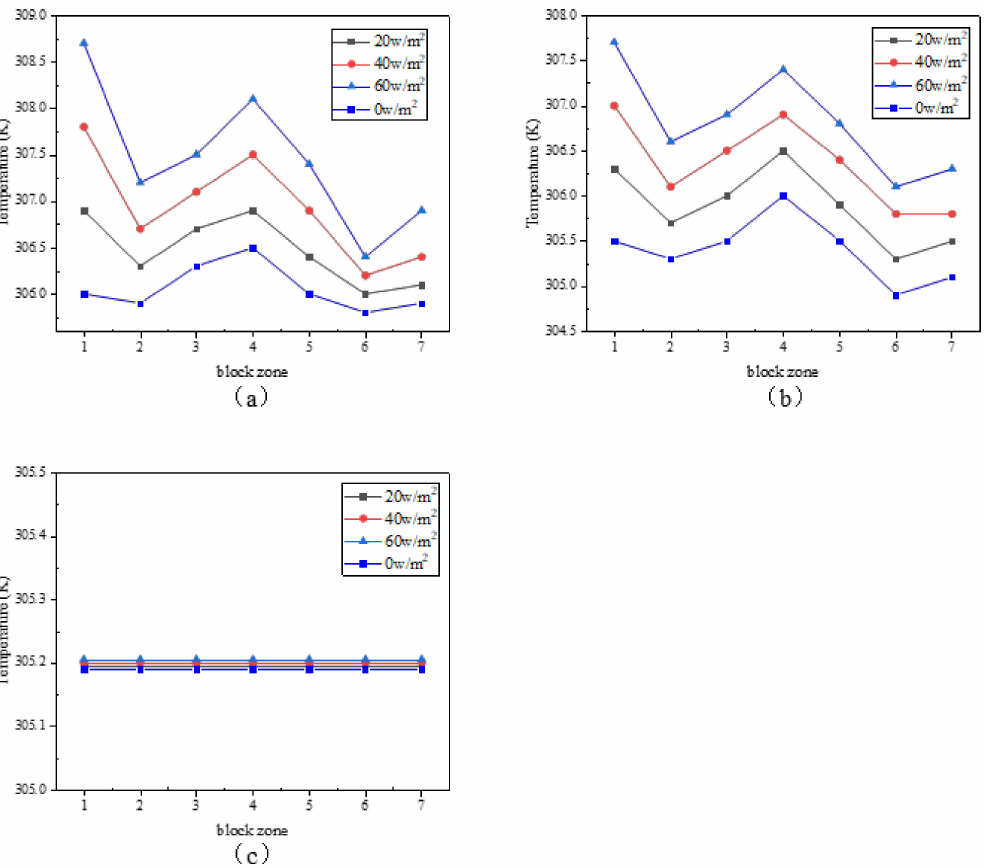
Figure 14. Temperature of the area corresponding to the heights of 2 m ( a ), 10 m ( b ), and 50 m ( c ) under different intensities of anthropogenic